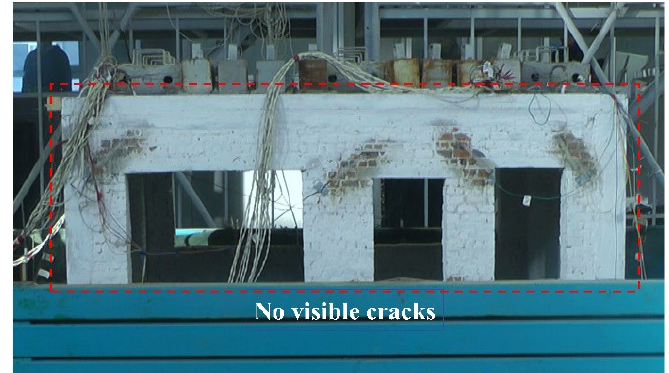
( b ) Figure 11. Curve of shear modulus ratio and damping ratio of soil with shear strain: ( a ) natural soil; ( b ) RSM. Table 4. Basic physical and mechanical parameters of soil. Type of Soil